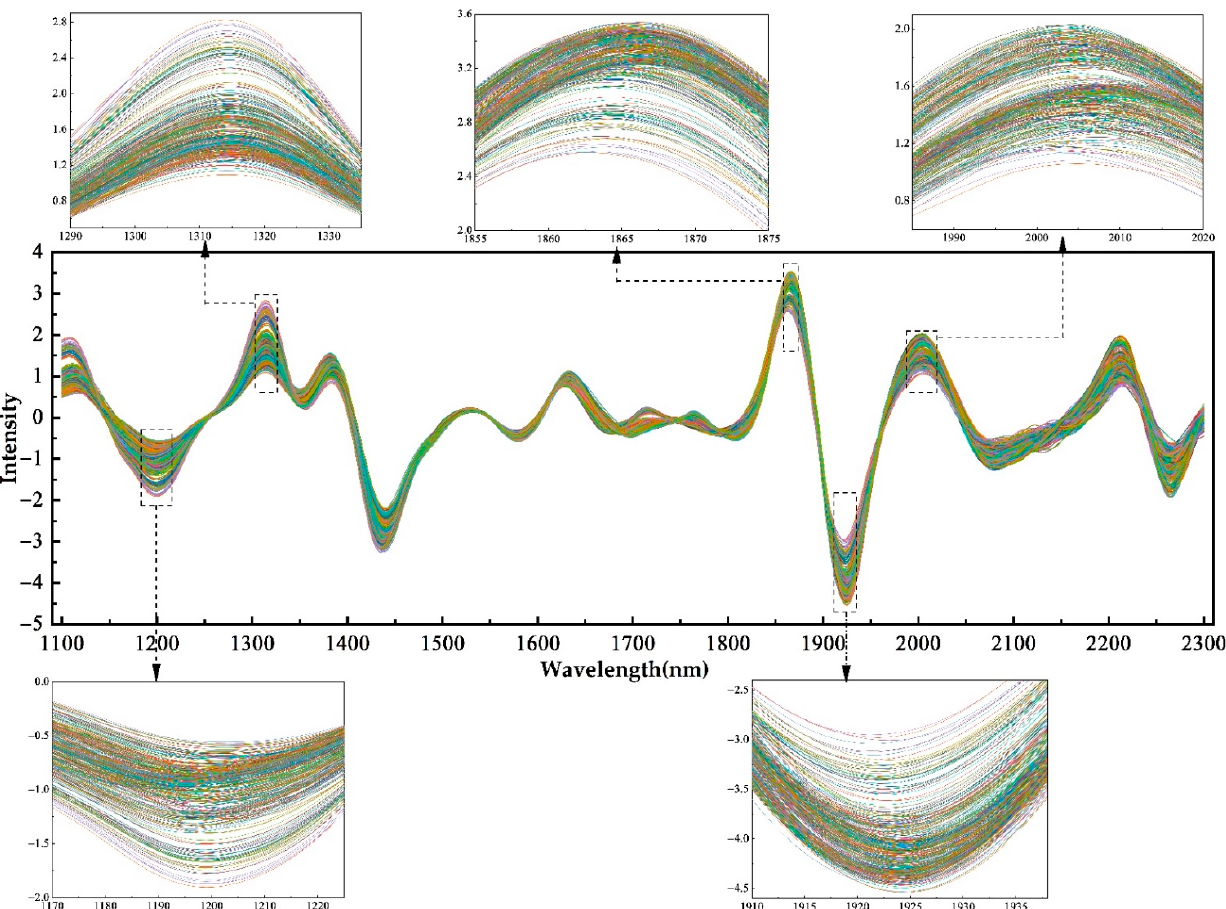
Figure 5. Partial wood transverse Section 1100–2300 nm NIR spectra after preprocessing with the combination of smoothing, the second derivative, and SNV.